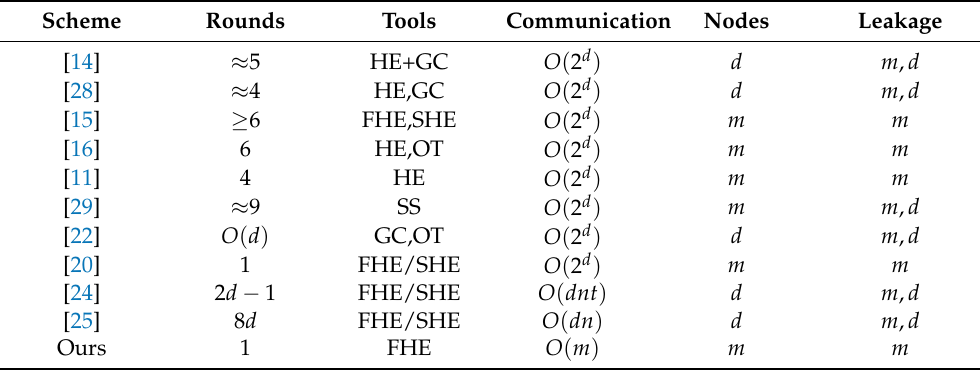
Table 2. Theoretical performance analysis of private decision-tree-classification protocols. The column “Communication” is the bandwidth complexity of the decision tree. The column “Nodes” is the quantity of nodes running the comparison algorithm in the evaluation. Scheme Rounds